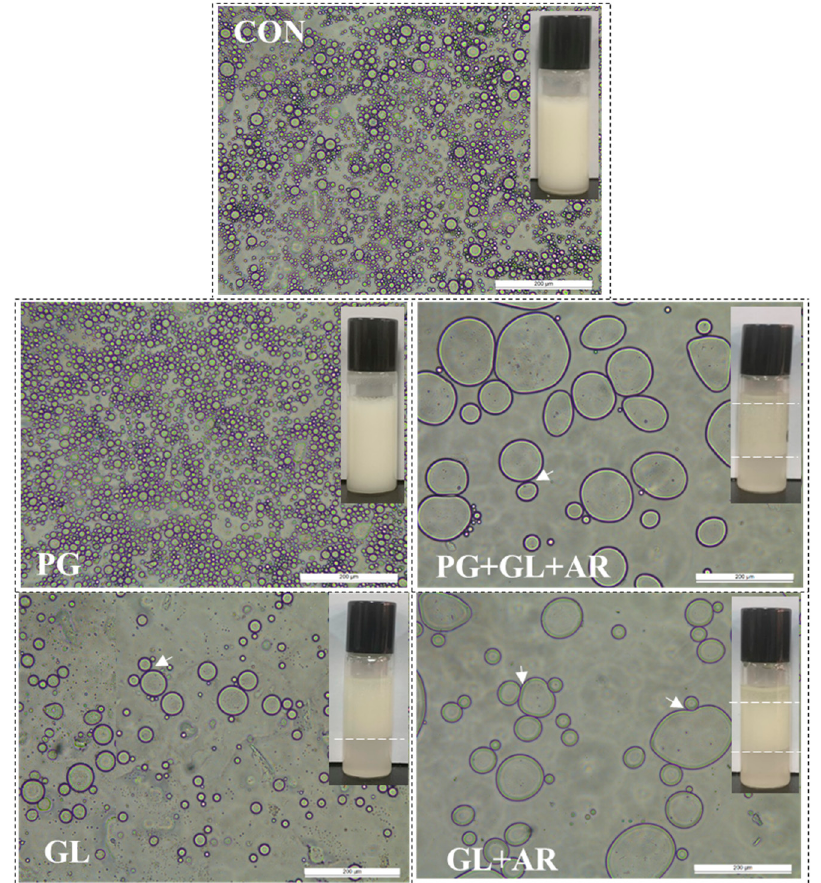
Figure 4. Micrographs and photographs (insets) of emulsions stabilized (pH 7.0) with enzyme-treated OKPs (0.5% w / v ) after 15 days of storage at 25 °C. Oil fraction φ = 0.5. Scale bars, 200 μ m. White arrows indicates droplets aggregation